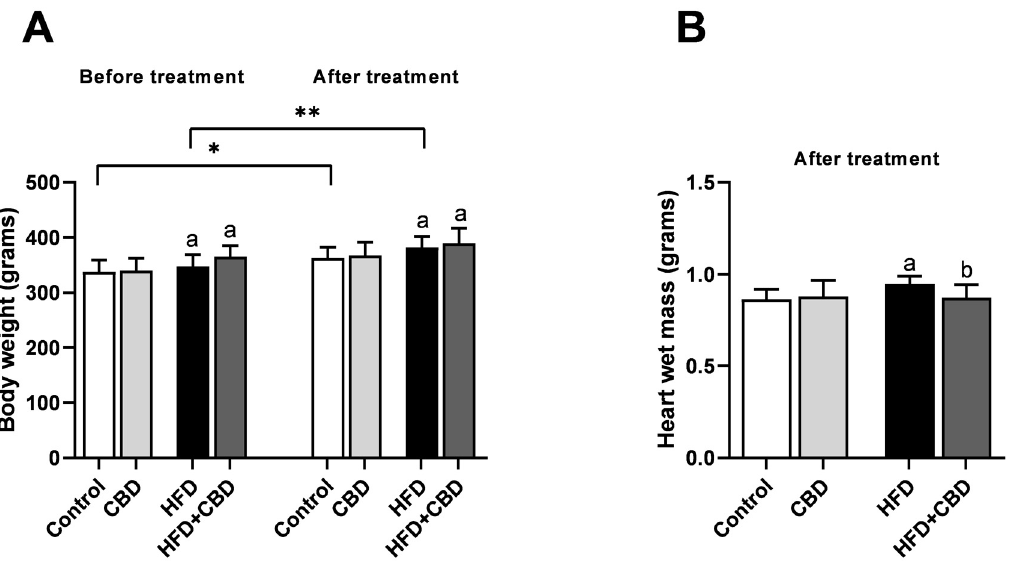
Figure 1. Body and heart weights parameters before and/or after 2-week cannabidiol (CBD) treatment in rats fed a standard diet (Control) or a high-fat diet (HFD). The results are expressed as mean values ± SD and are based on ten independent determinations in each experimental group. a p < 0.05 significant difference vs. respective control group, this refers to Figure 1A,B; b p < 0.05 significant difference vs. high-fat-fed group, this refers to Figure 1B; * p < 0.05 significant difference between control groups before and after CBD treatment ** p < 0.05 significant difference between high-fat-fed groups before and after CBD